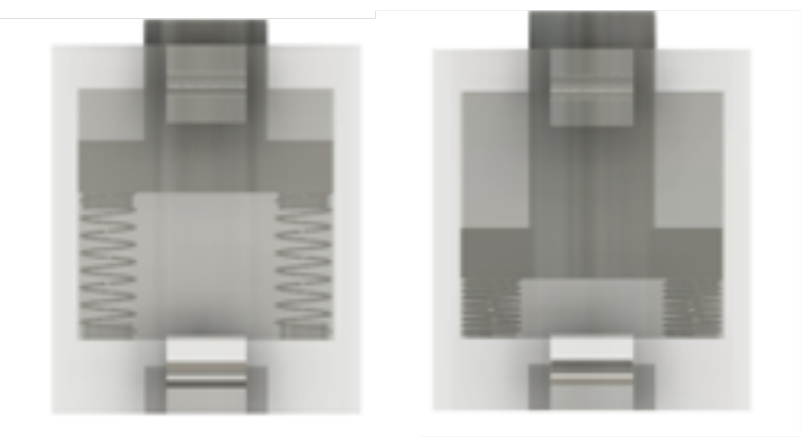
Figure 6. The model of the buffer with springs. The left subplot shows the case where the springs are stretched. The right subplot shows the case where the springs are